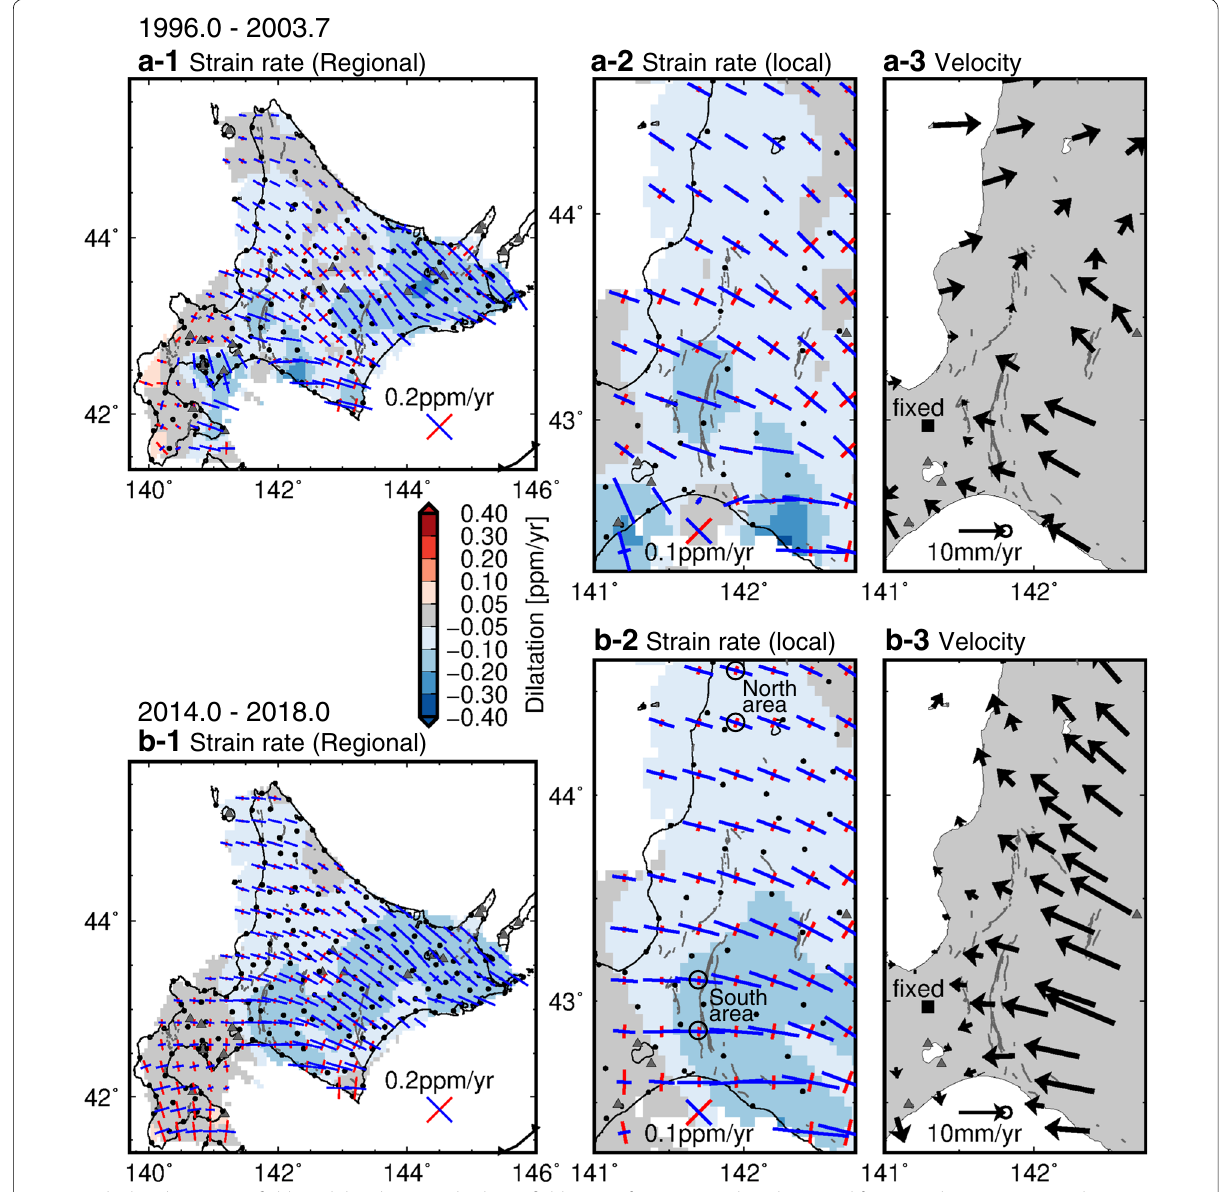
Fig. 2 Calculated strain rate fields and their horizontal velocity field source for two periods: a the period from March 1996 to September 2003; a-1 regional distribution of dilatation and principal strain rate in Hokkaido. Dilatation rates with colors and principal strain vectors at every 0.25° were estimated from the velocity field. Positive dilatation rate values indicate expansion. The red and blue colors for principal strain indicate extension and contraction, respectively. a-2 Enlarged view of the study area. a-3 Horizontal velocity field with respect to site 0128 (Sapporo). b-1 , b-2 , and b-3 are identical to a-1 , a-2 , and a-3 , respectively, but for the period between January 2014 and December 2017. The four grids with open circles in b-2 are areas that are characterized by changes in temporal strain, as shown in Fig.